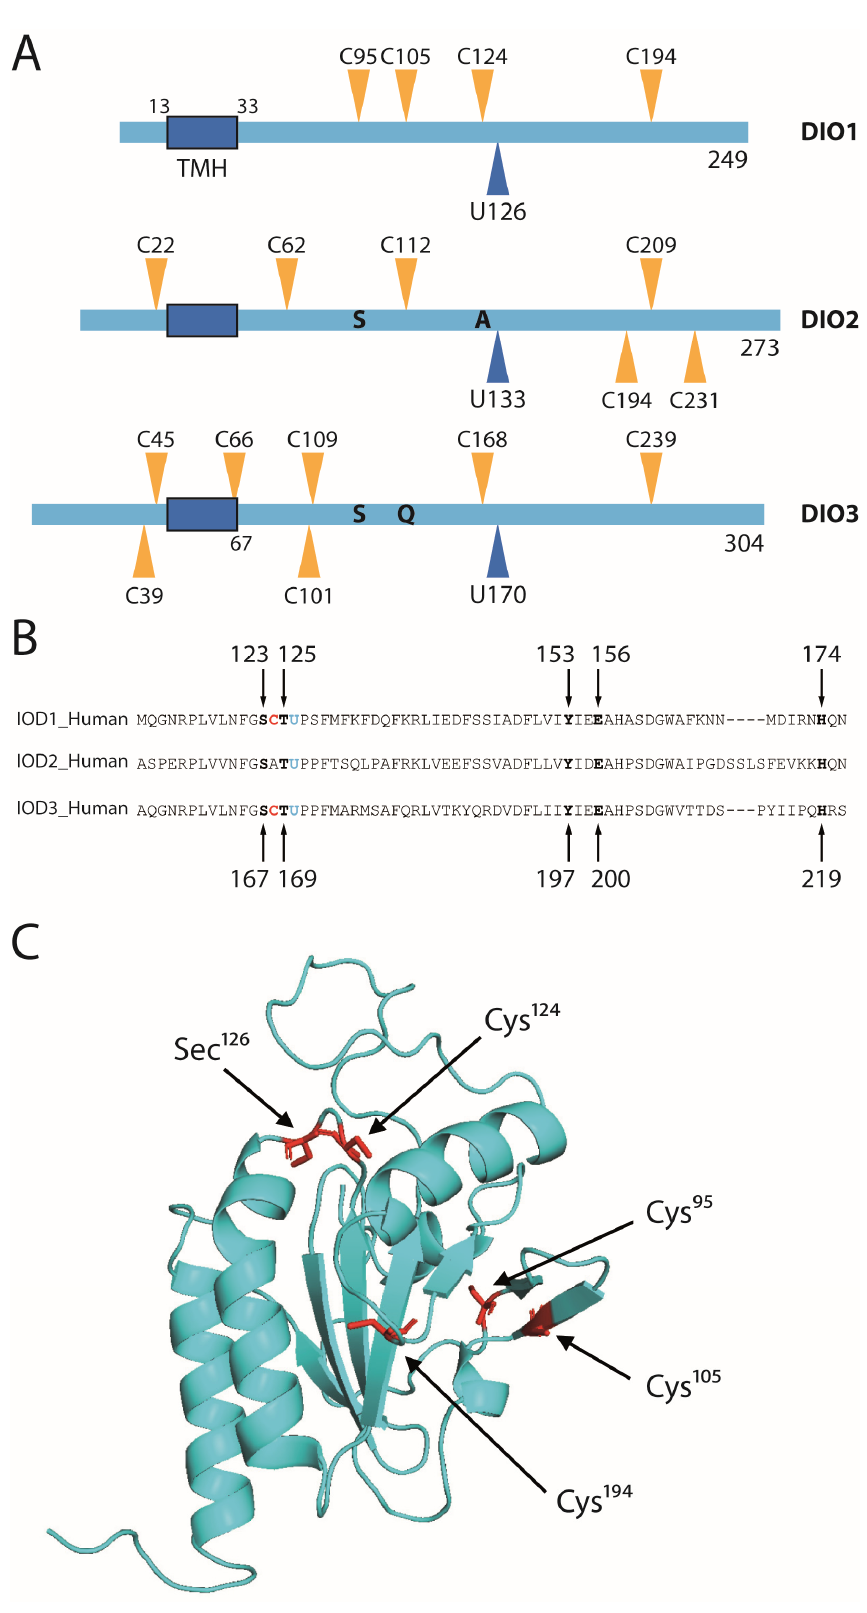
Figure 1. Conserved amino acid positions in deiodinases. ( A ). Cysteines in human DIO1-3. TMH transmembrane helix. ( B ). Primary sequence surrounding the catalytic Sec (U) and Cys (C) in DIO1-3. ( C ). Spatial orientation of conserved cysteines. Homology model of human DIO1 based on mDIO3 cat (PDB